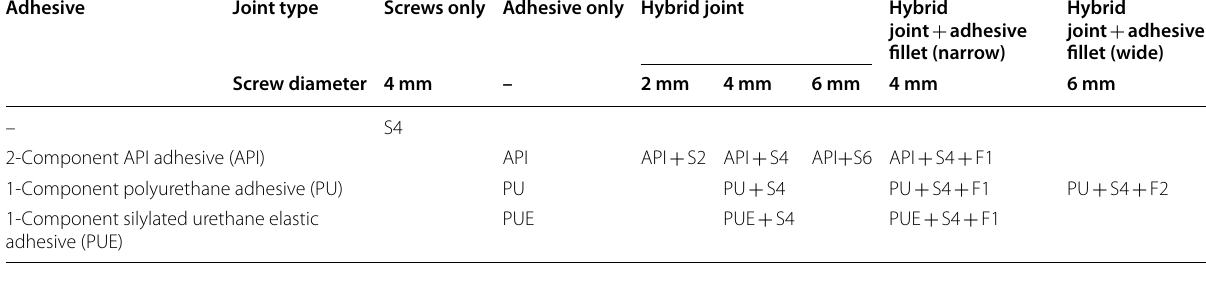
adhesive fillet (narrow), and c hybrid joint +